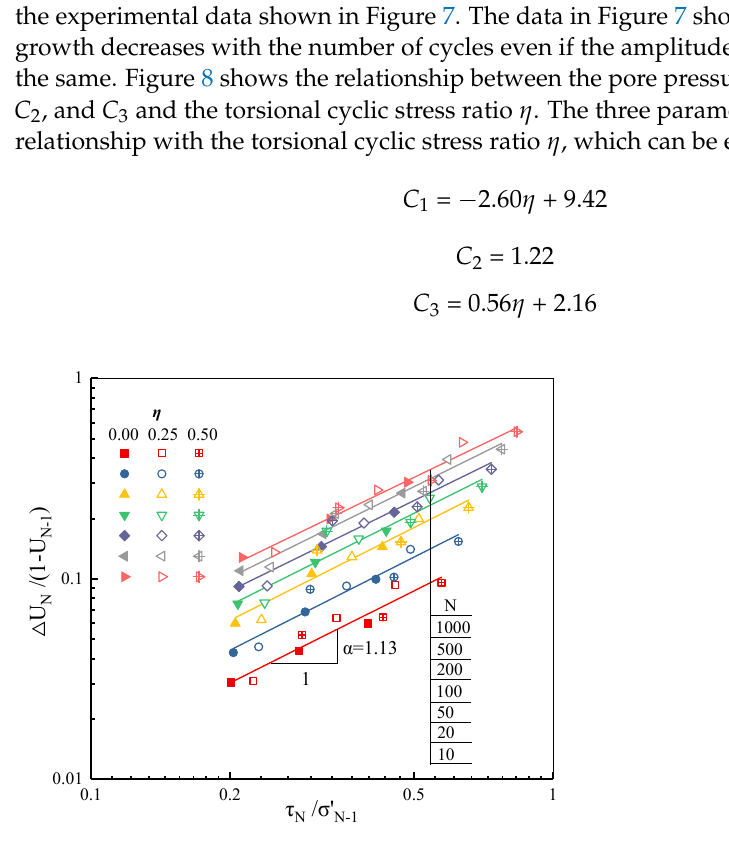
Figure 6. Pore pressure increase with different cycles.